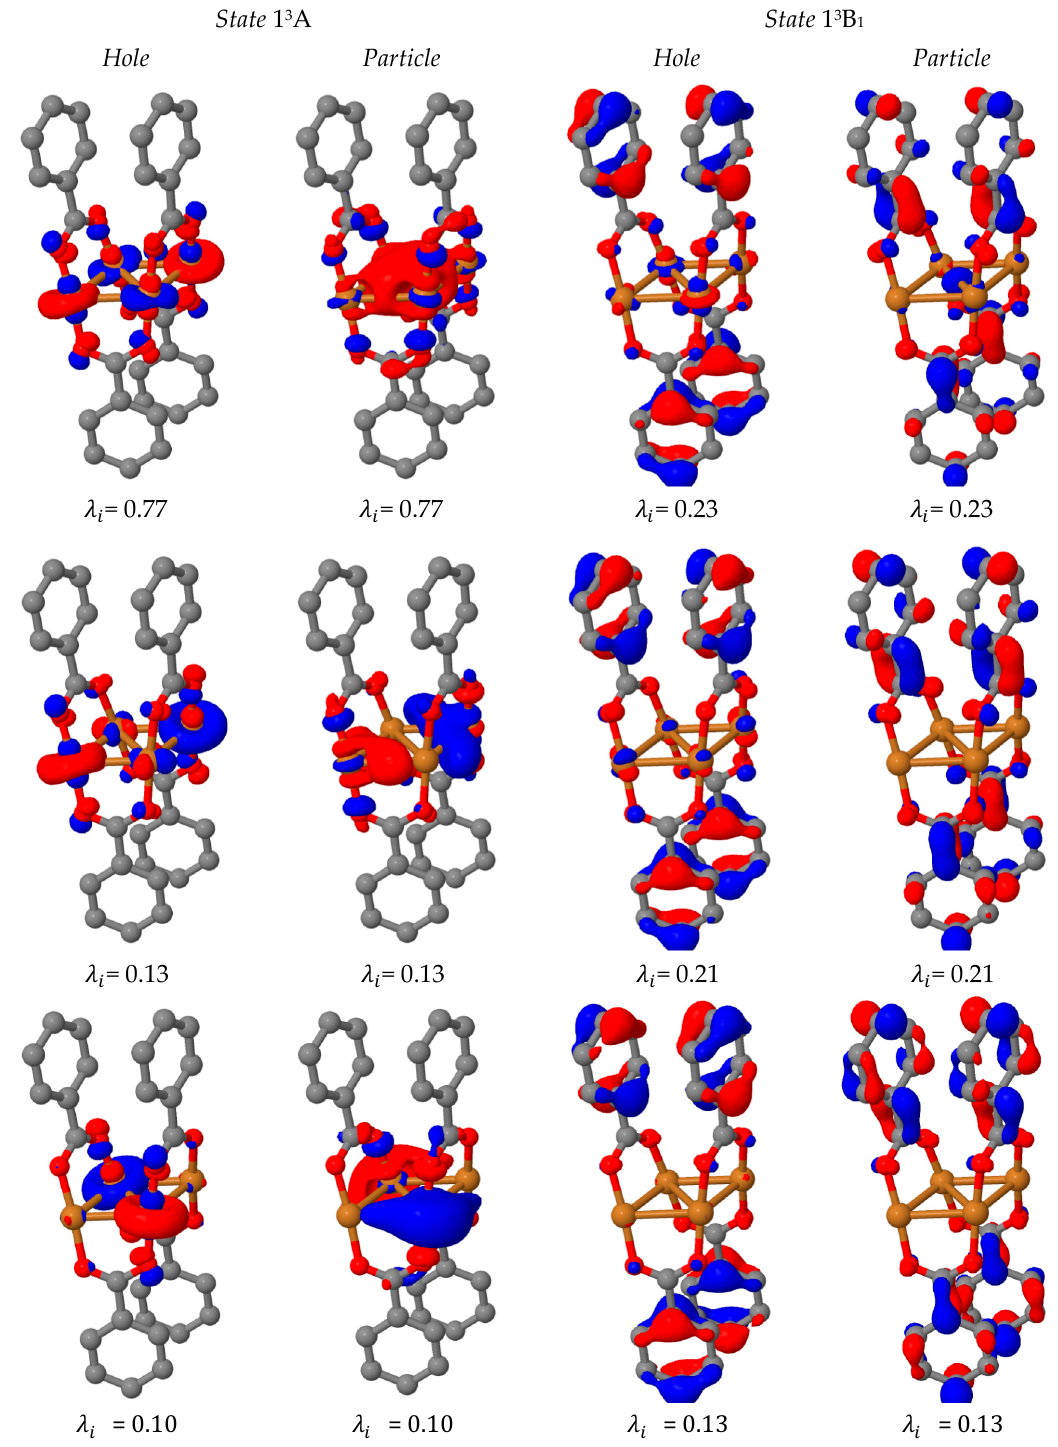
Figure 8. Dominant hole and particle NTOs ( λ i ≥ 0.1) for the 1 3 A and 1 3 B 1 states of Cu 4 (isosurfaces drawn at ±0.04 a.u.; blue—positive; red—negative) obtained at the CAM-B3LYP/cc-pVDZ level of theory.